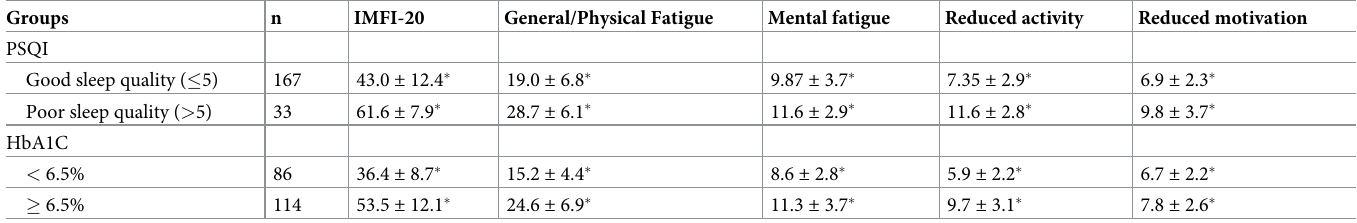
Table 4. Known group validity of IMFI-20 for different level of variables (n =